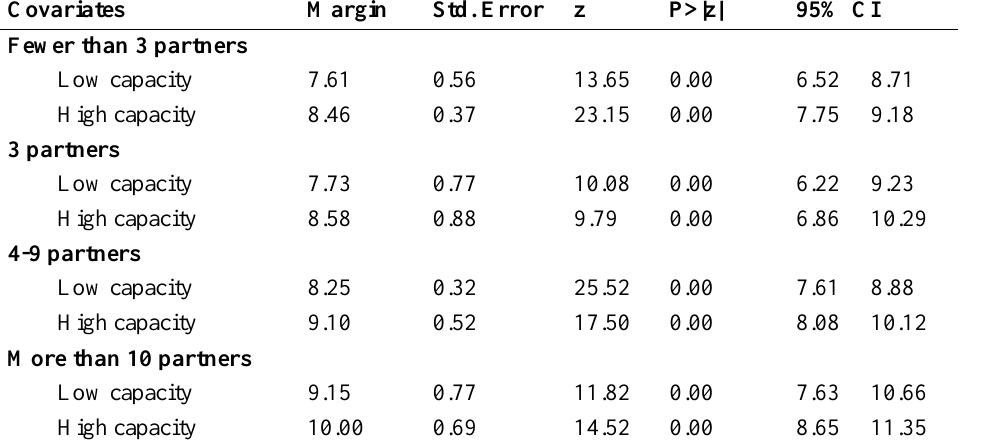
Table A1.1 Statistical significance for the predicted values (margins) of perceived success by number of organizational partners per county and land trust organizational capacity